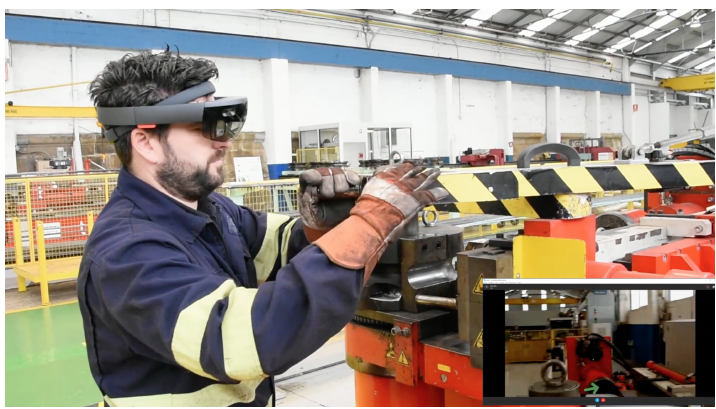
Figure 6. One of the tests in the pipe workshop with the HoloLens augmented collaboration application.